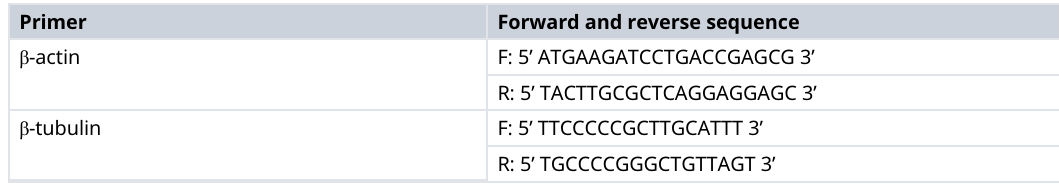
Table 1. Primers for DNA amplification. Primer